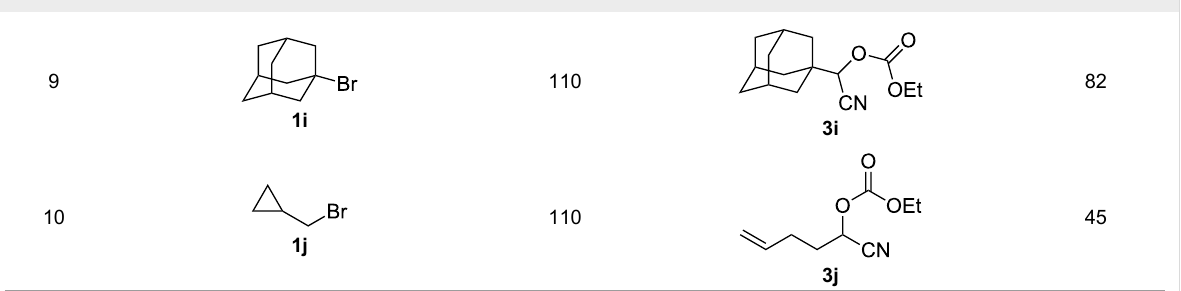
Table 1: Three-component coupling reaction leading to cyanohydrin derivatives.